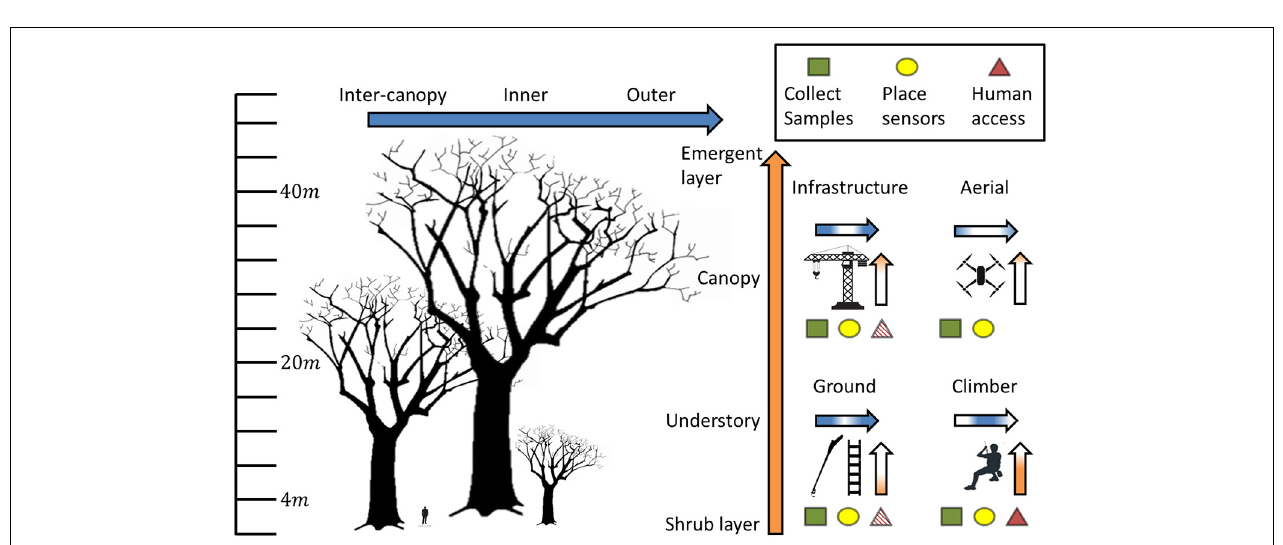
FIGURE 6 | Frequency of tree canopy access reported by respondents given (A) their current methods of access and (B) their desired level of access, if sampling were quick and effective.